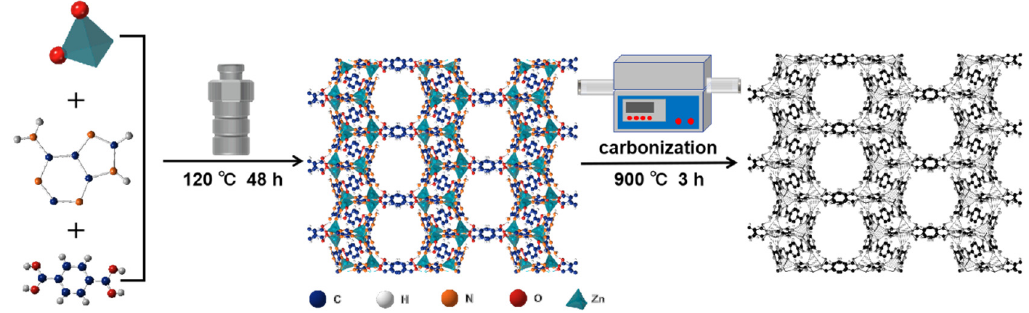
Figure 1. Schematic diagram of the synthesis of bio − 27 and its derivatives, bio − C materials.